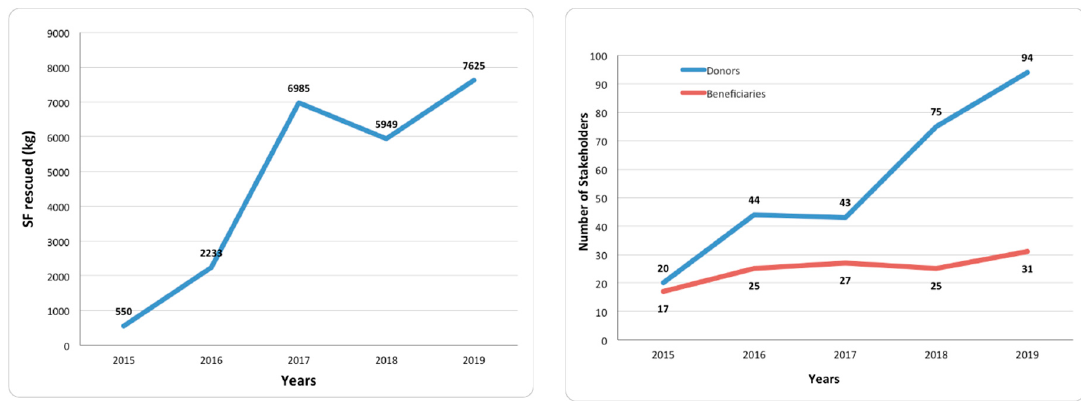
Figure 2. Amount of Surplus Food (SF) rescued (in kg) and number stakeholders involved in Avanzi Popolo 2.0 (AP) from 2015 to 2019. Source: own elaboration.